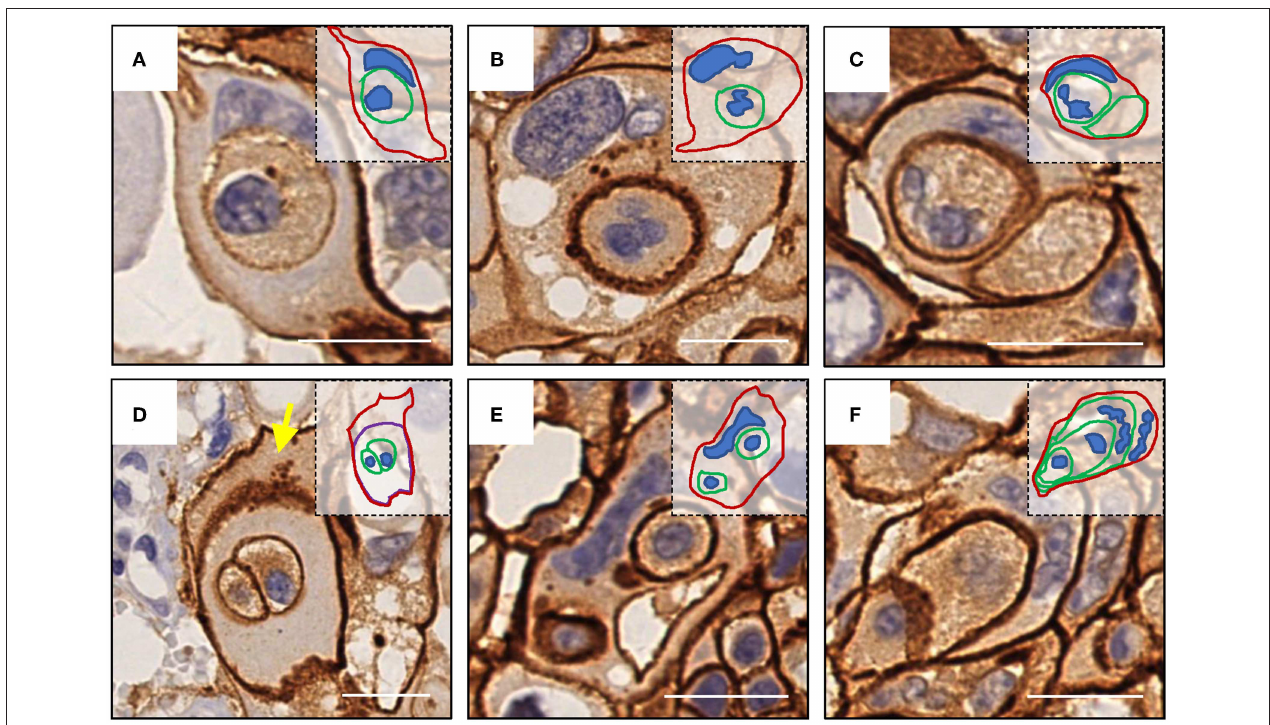
FIGURE 3 | Complex morphologies of CIC structures. (A) One cell was internalized. (B) abnormal nucleus of the outer cell. (C) Two cells were internalized, and the nucleus of one of them was missing. (D) The cell enclosing two cells was inside of another cell (yellow arrow) without nucleus. (E) Two cells were internalized, and the nucleus of the outer cell was deformed. (F) Sequential internalization of three cells. Inserted pictures are schematic cartoons for the indicated CIC structures, respectively. Scale bar: 20 µ